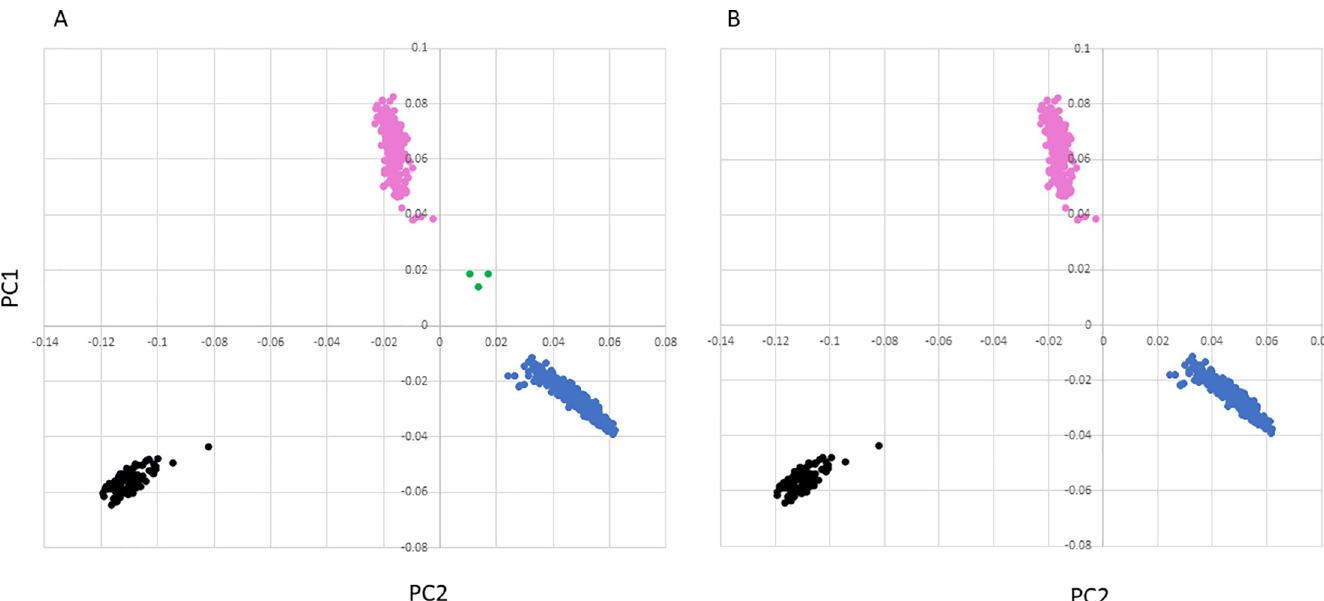
Fig 1. Plots of the first 2 principal components with 647 sheep showing breed outliers (A) and without the 3 outliers (B). Blue represents Rambouillet, pink represents Polypay, black represents Suffolk and green represents the 3